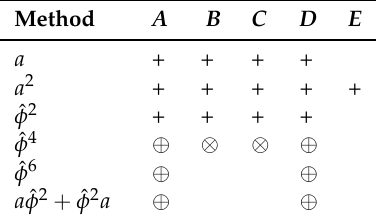
Table 1. Comparison of the mean values calculated by the different methods. Capital letters denote a method. A plus implies that the values obtained by the different methods coincide. Crosses of two types in a circle mean that the values obtained at least by two different methods